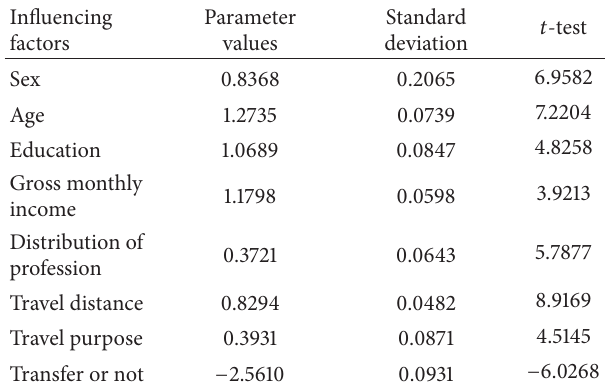
Table 2: The calibration results of influencing